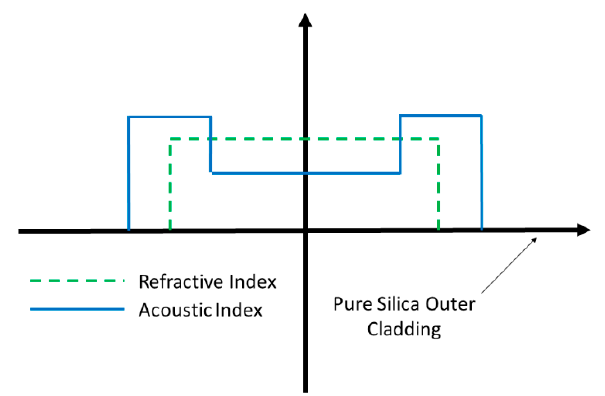
Figure 8. Example acoustic and refractive index profiles for the equalization of Brillouin gain between the L 01 and higher order acoustic modes. In this configuration, the optical and acoustic boundaries are decoupled [138].